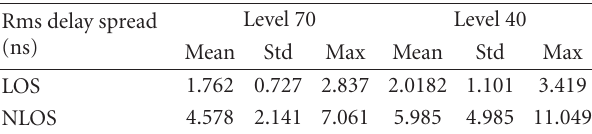
Table 4: RMS delay spread in LOS and NLOS cases with directive Antenna.